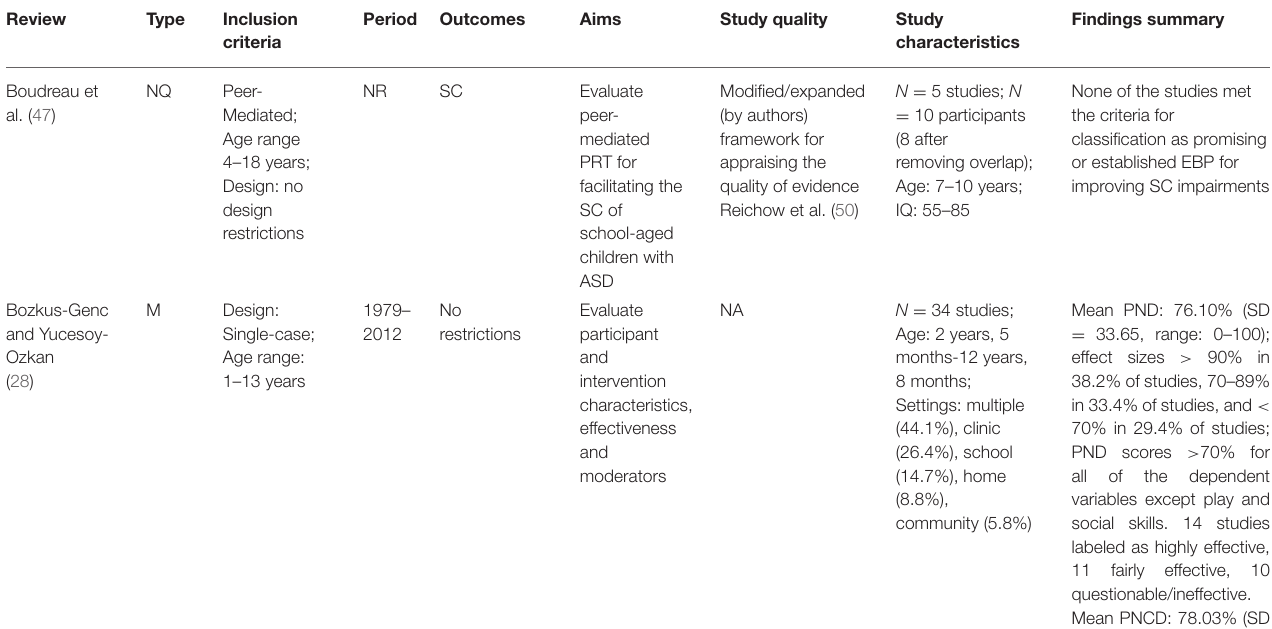
TABLE 2 | Overview of the characteristics and findings from the identified systematic